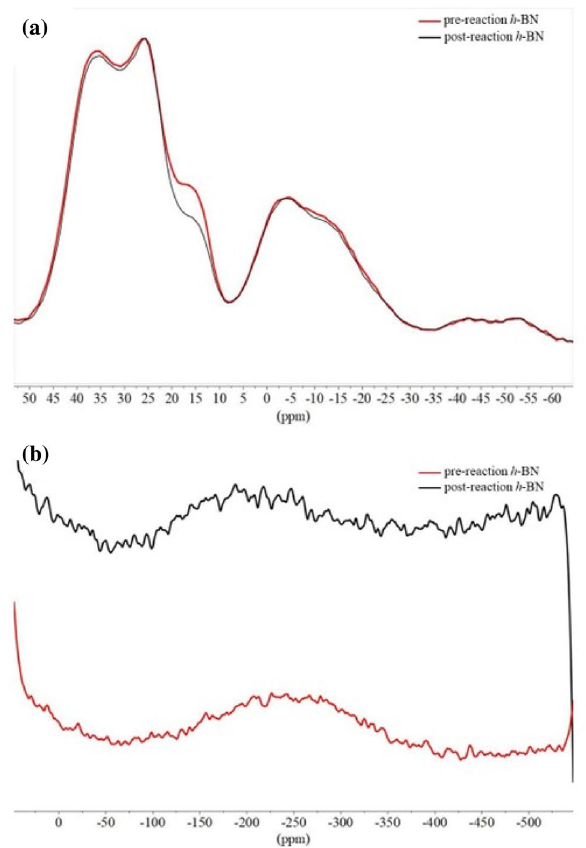
Figure 6. ( a ) MAS 11 B SS-NMR spectra, ( b ) 15 N SS-NMR spectra of pre- and post-reaction h -BN. Reaction